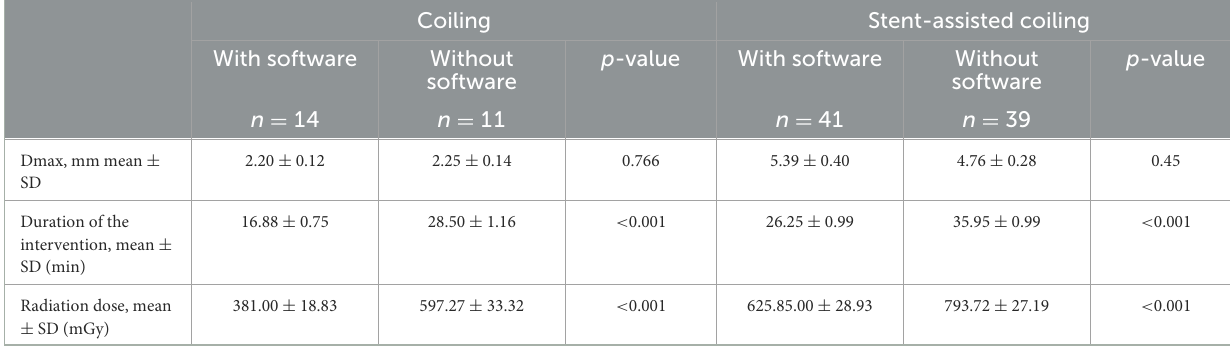
TABLE 4 Software-based microcatheter shaping techniques reduce operating time and radiation dose both in coiling-only group and stent-assisted coiling group.